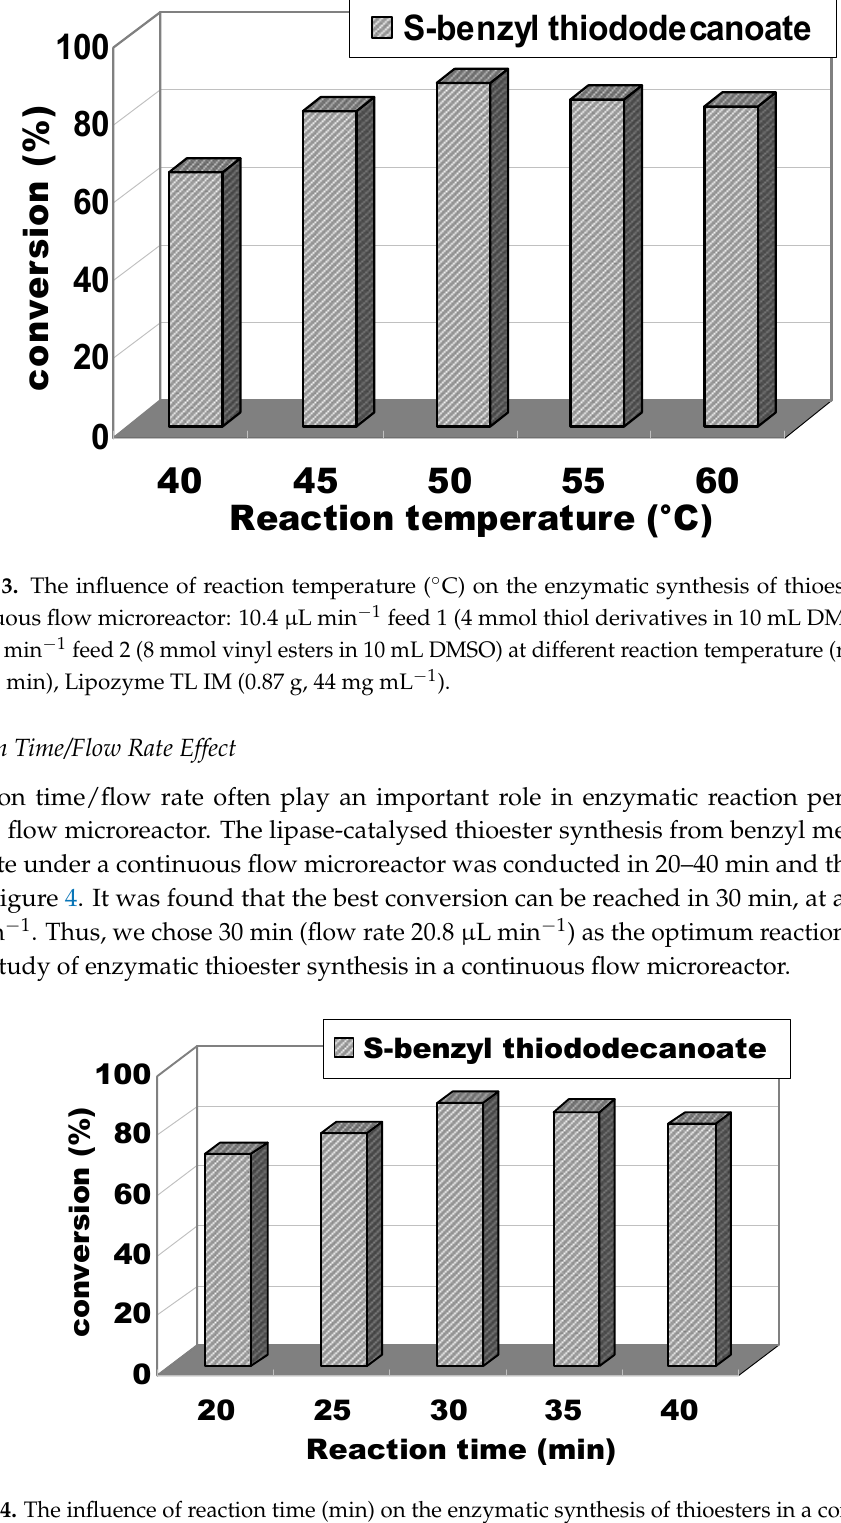
Figure 4. The influence of reaction time (min) on the enzymatic synthesis of thioesters in a continuous flow microreactor.